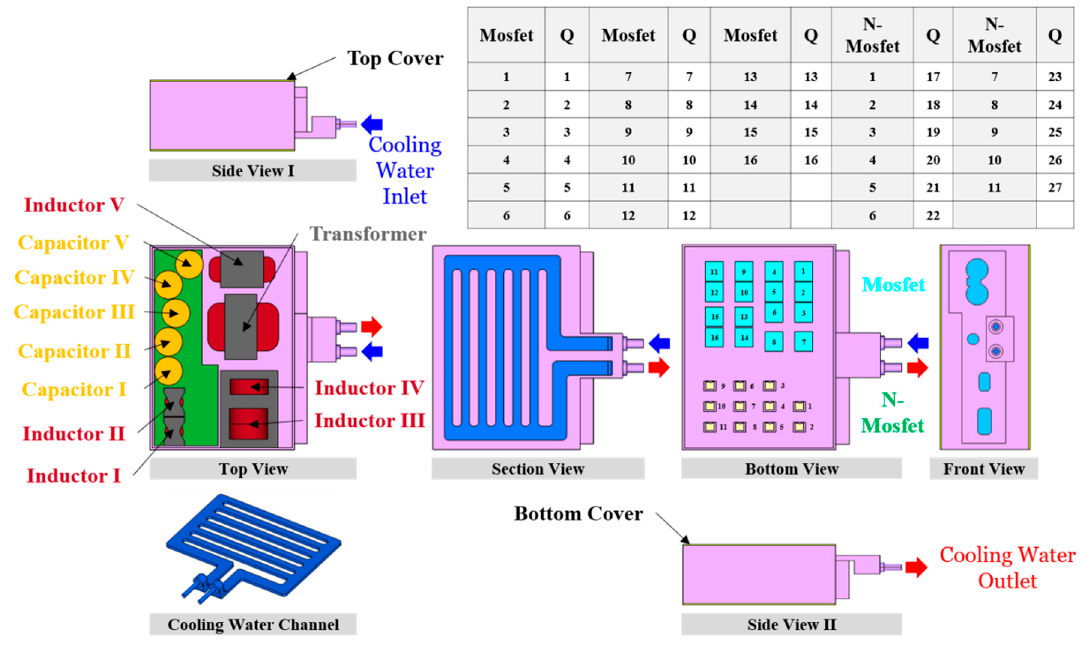
Figure 5. Geometry of the 7.2 kW integrated bidirectional OBC/LDC module.